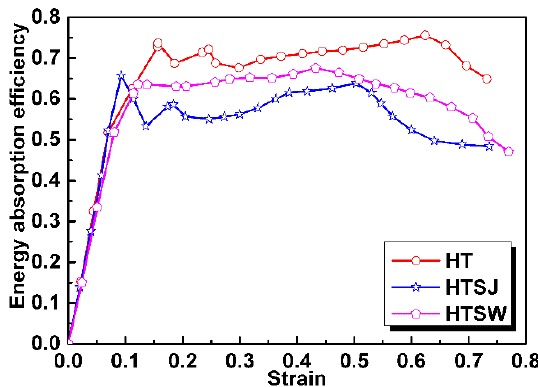
ffi ciency of the